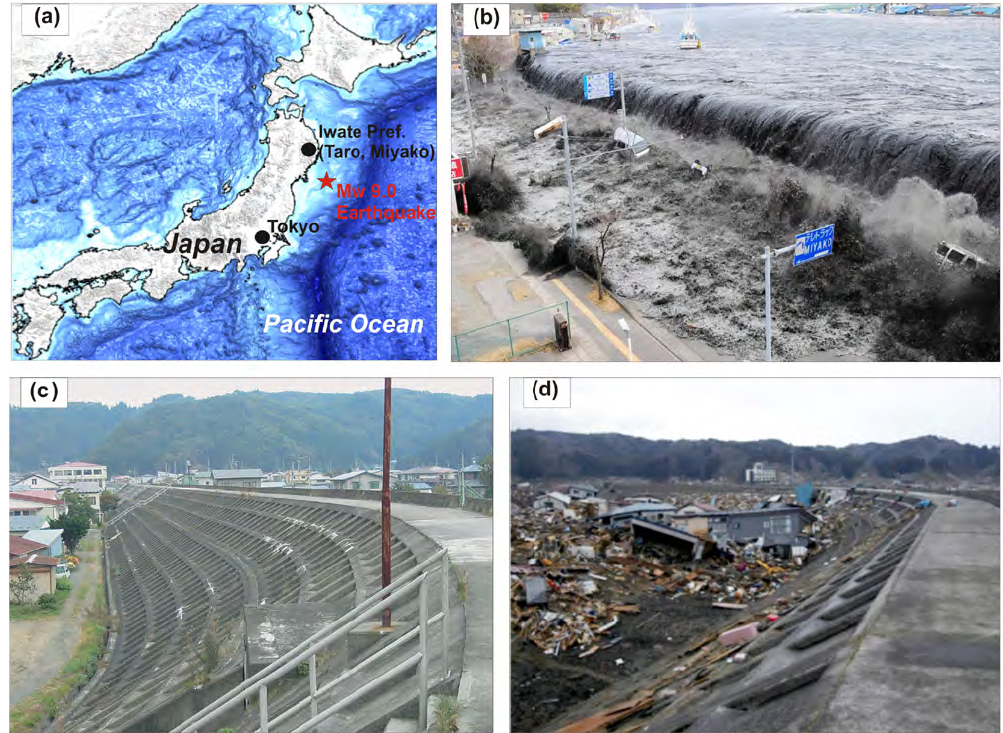
Fig. 1. The Tohoku, 11 March 2011, Tsunami event of Japan: (a) epicentre location of the earthquake from USGS (2011); (b) the 11 March tsunami overtopping the 40ft sea-wall at Miyako city (source: Mainichi Shimbun/Reuters in The New York Times, 2011a); (c) sea-wall of 10m height in Taro N-E Japan (adapted from Edward et al., 2006); (d) the devastating impact in the city of Taro after the 11 March 2011 Japanese tsunami that overtopped the sea-wall (source: Ko Sasaki for The New York Times,